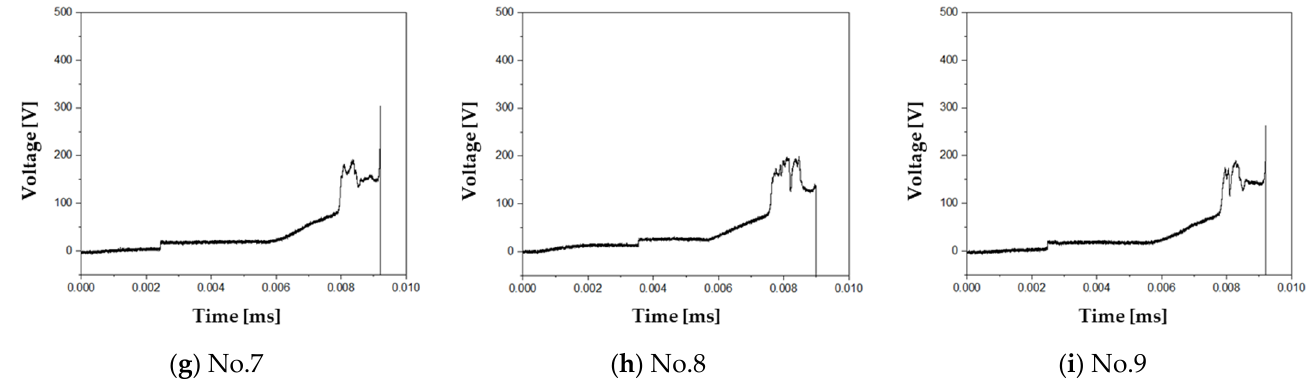
Figure 8. Short-circuit characteristics at 45 °C. Table 2. Short-circuit characteristics test results according to temperature.